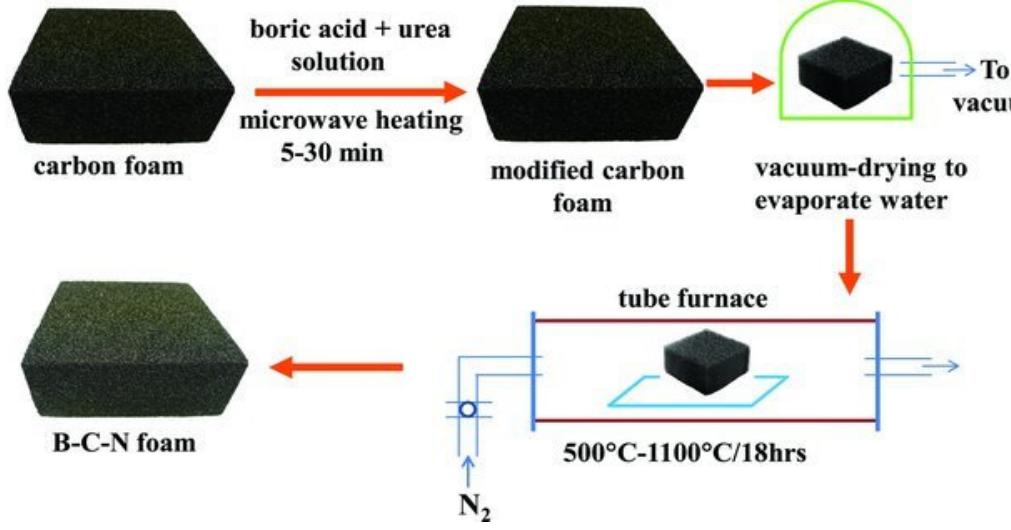
Figure 6. Schematic synthesis procedure of B-C-N foam from carbon foam. Reprinted with permission from the authors of [74]. Copyright © (2012) John Wiley & Sons.